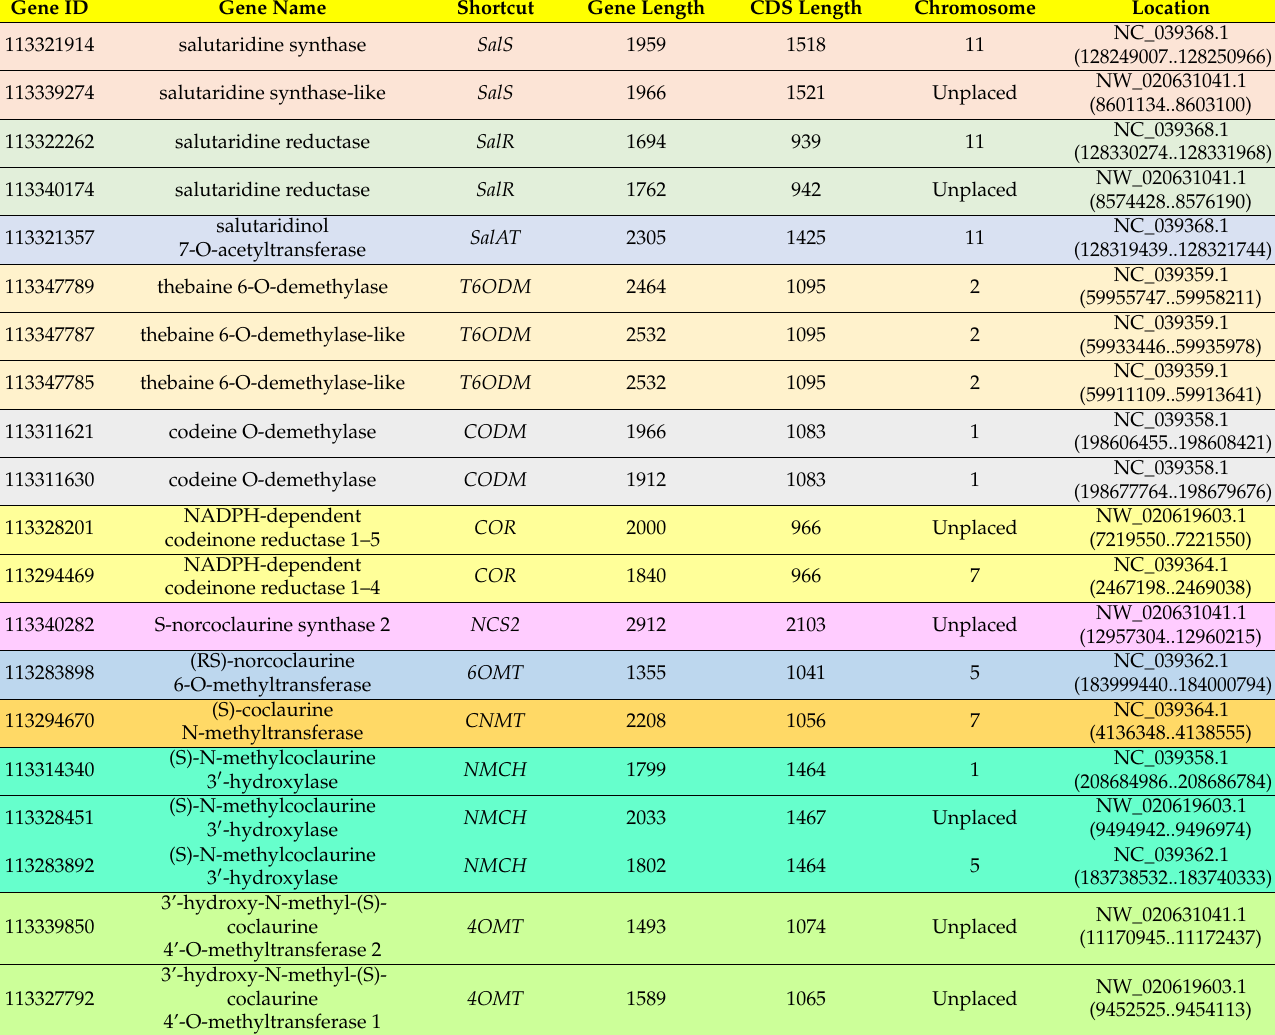
Table 1. Genes of morphine production pathway in opium poppy. The same genes are shown in the same